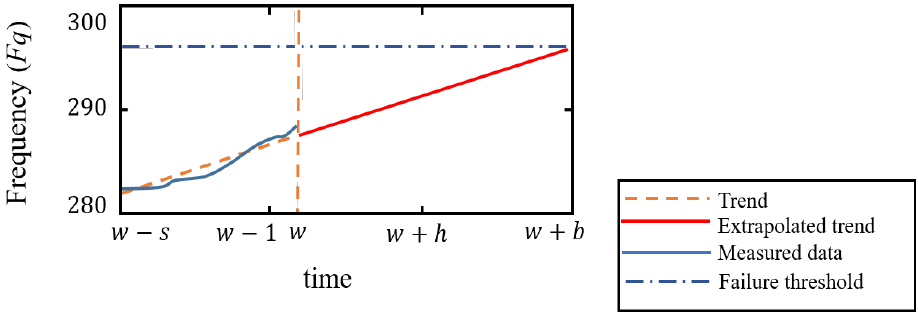
Figure 7. Forecasting notation.